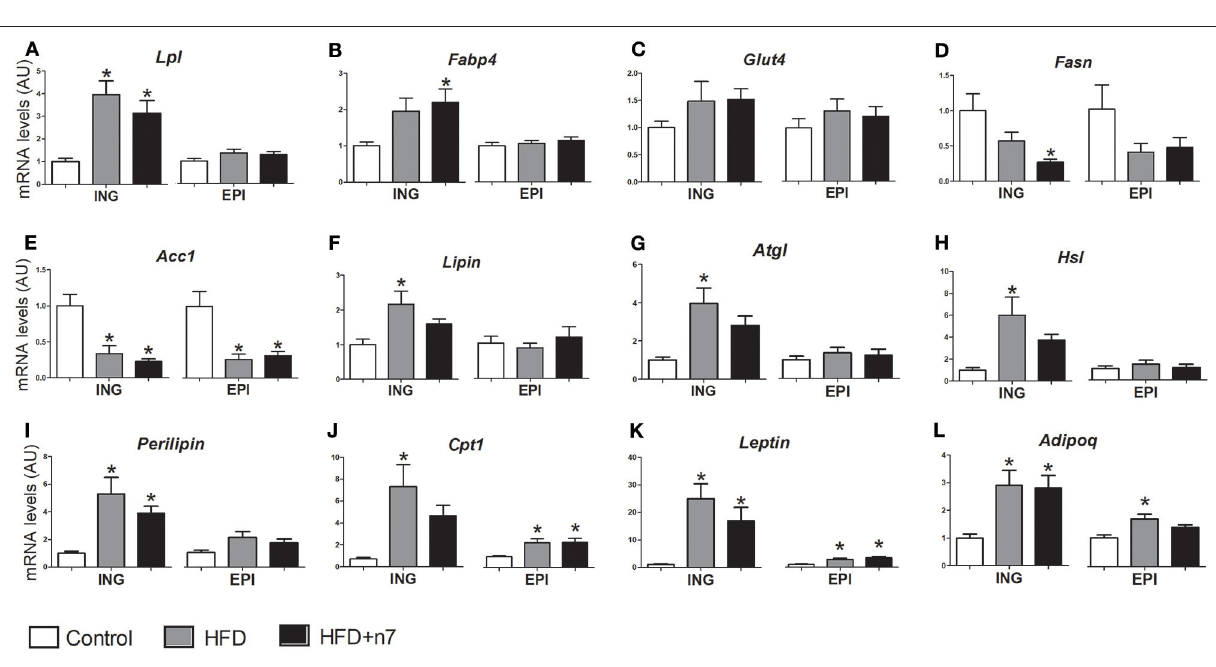
FIGURE 3 | mRNA levels of Lpl (A) , Fabp4 (B) , Glut4 (C) , Fasn (D) , Acc1 (E) , lipin (F) , Atgl (G) , Hsl (H) , perilipin (I) , Cpt1 (J) , leptin (K) , Adipoq (L) expressed by isolated adipocytes from ING and EPI fat depots in arbitrary units (AU), normalized by Gapdh . Results were expressed as mean ± SEM ( n = 12). Data were analyzed by one-way ANOVA. * p < 0.05 vs.